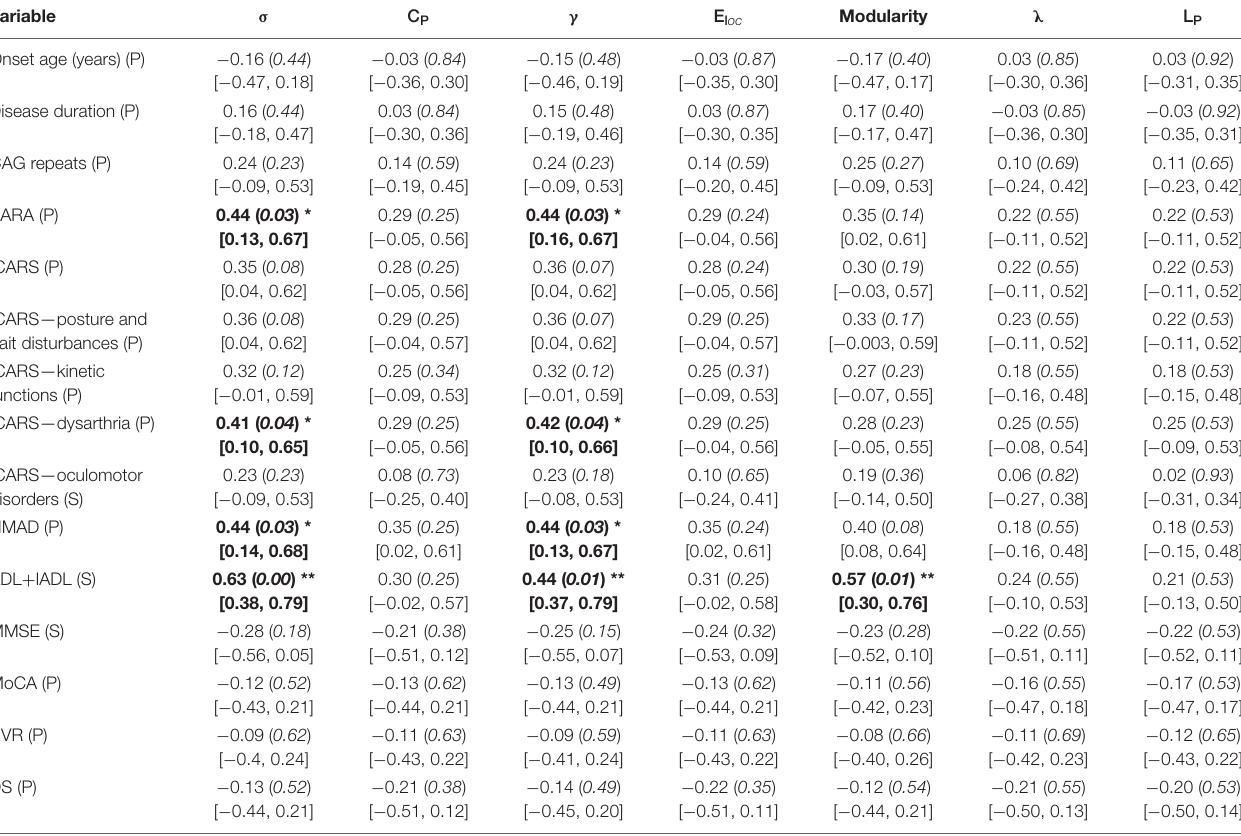
TABLE 2 | Correlations between global neuroimaging attributions and clinical variables.